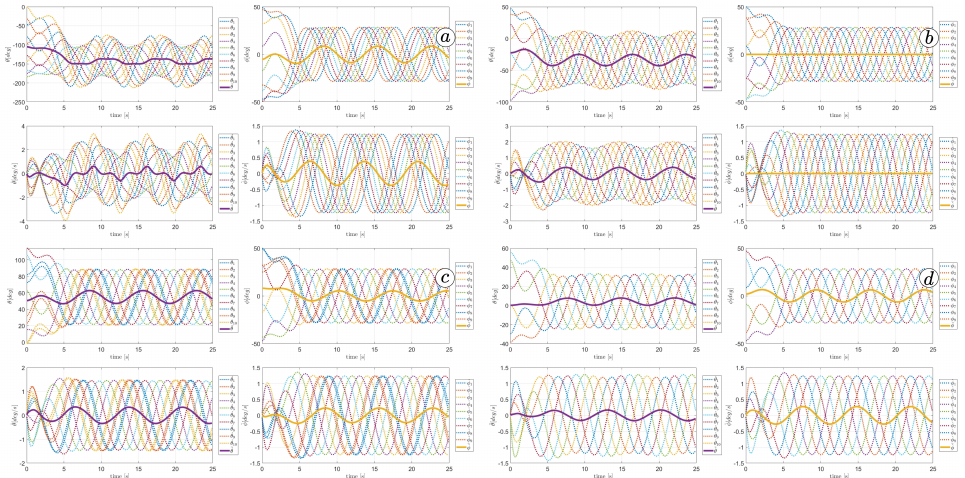
Figure 37. Values of link angles θ , joint angles φ , link angles derivatives ˙ θ , and joint angles derivatives